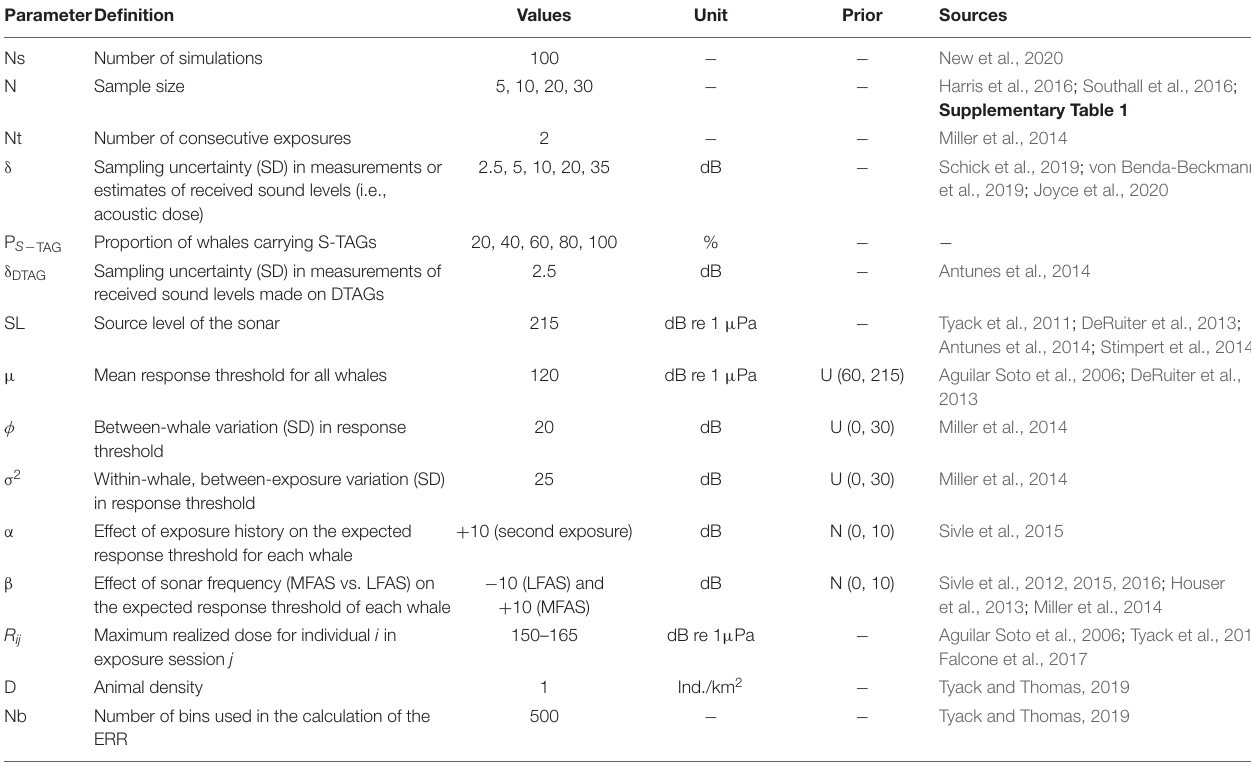
TABLE 1 | Parameters used in simulations of Cuvier’s beaked whale ( Ziphius cavirostris ) behavioral responses following exposure to mid-frequency and low-frequency active sonar.